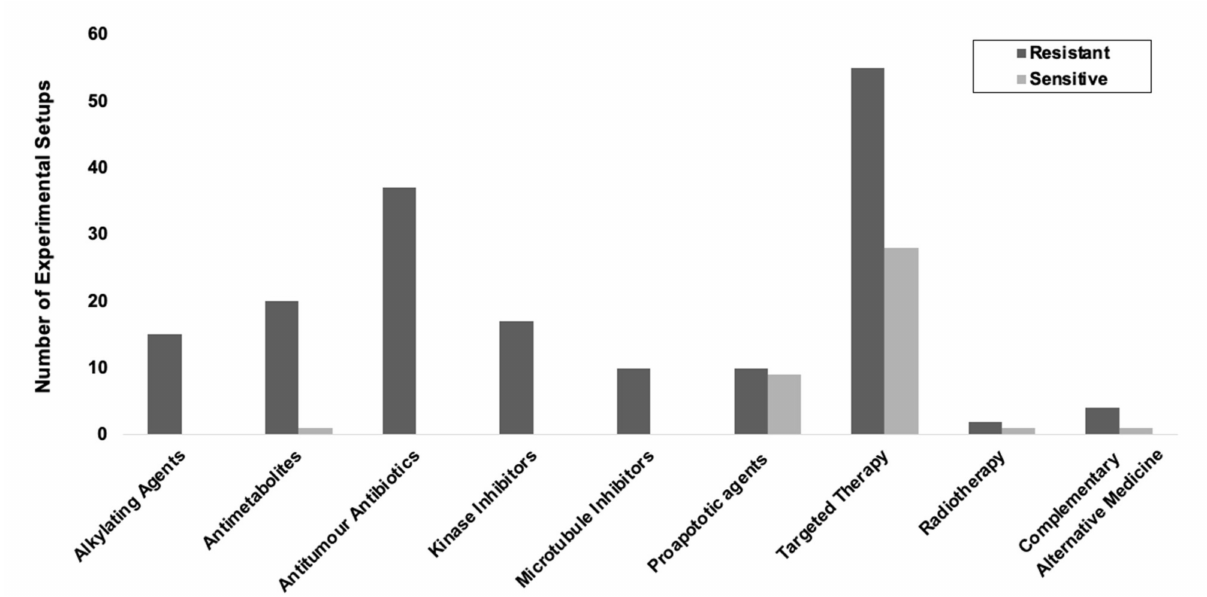
Figure 6. Cancer cell resistance or sensitivity to chemotherapy agents. Response to all therapy classes conveyed a trend of increased resistance to therapy in 3D in vitro tumour cultures compared to 2D cultures. Furthermore, five out of six of the conventional chemotherapy classes expressed congruent response of increased resistance to therapy in all experimental setups in 3D compared to 2D.